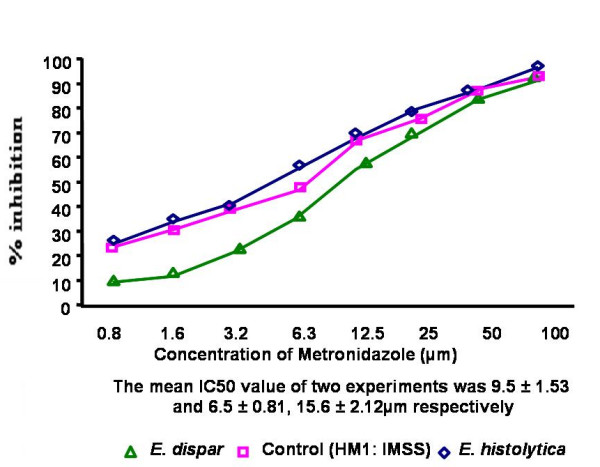
Percentage inhibition of E. histolytica (HM1: IMSS) and clinical isolates of E. histolytica and E. dispar by metronidazole